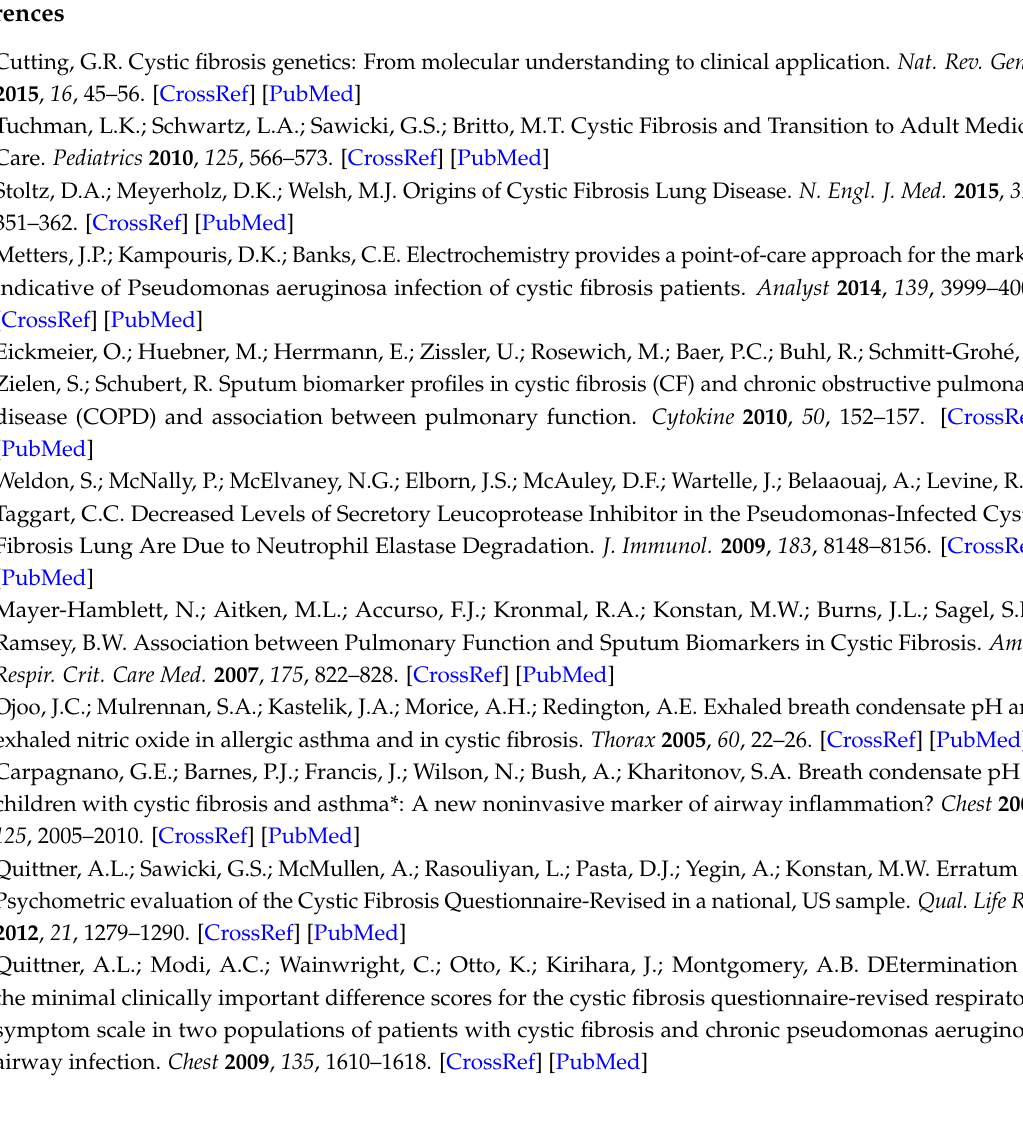
Figure S1: CAD images of 3D printed enclosure for electronic device, Figure S2: Sensor response to temperature variation and calibration of pH, Table S1: Bill of materials, Video S1: Smartphone pH Sensor